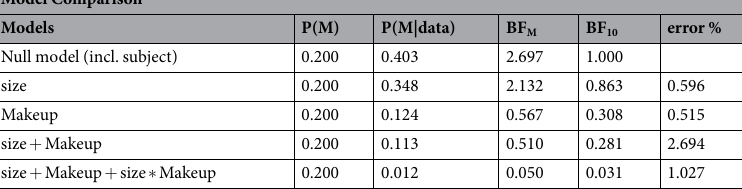
Table 4. Model comparison outputs for the results of Experiment 3B. Note . All models include